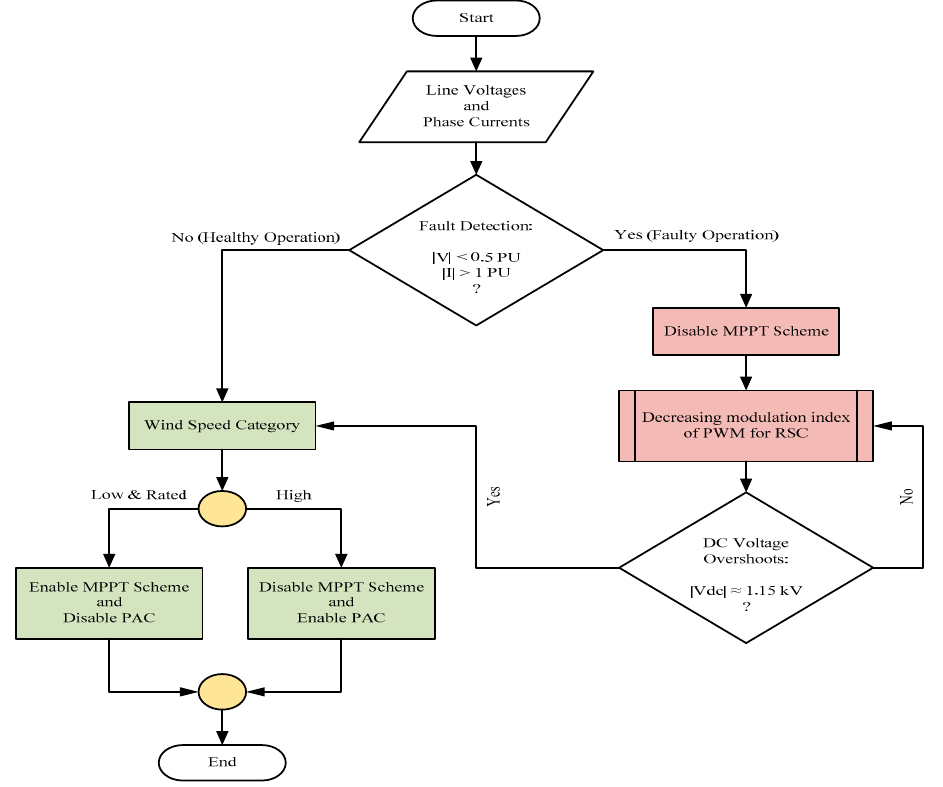
Figure 1. Proposed scheme for the fault tolerant control (FTC) controller. PAC, pitch angle control; MPPT, maximum power point tracking; RSC, rotor side converter.